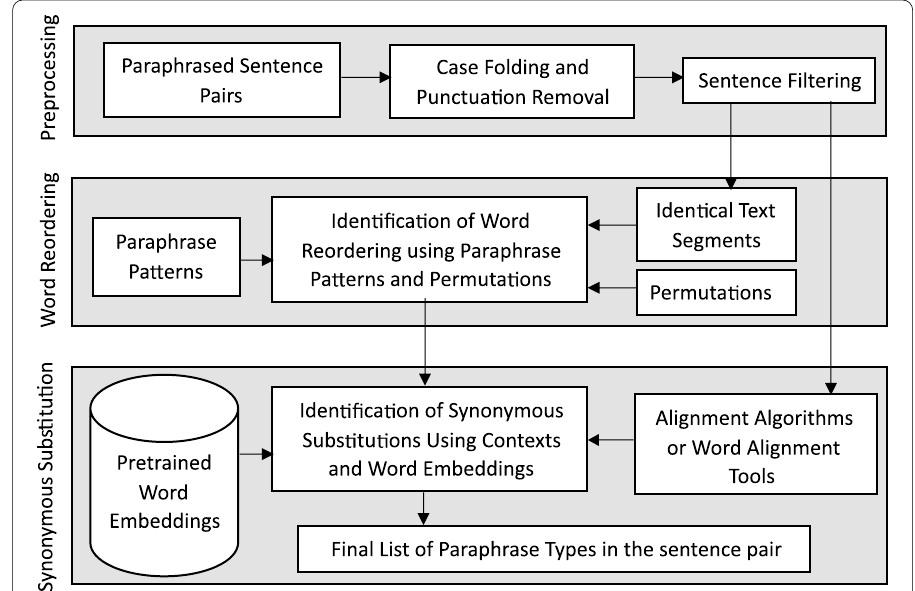
Fig. 6 Block Diagram of the Proposed Three Staged